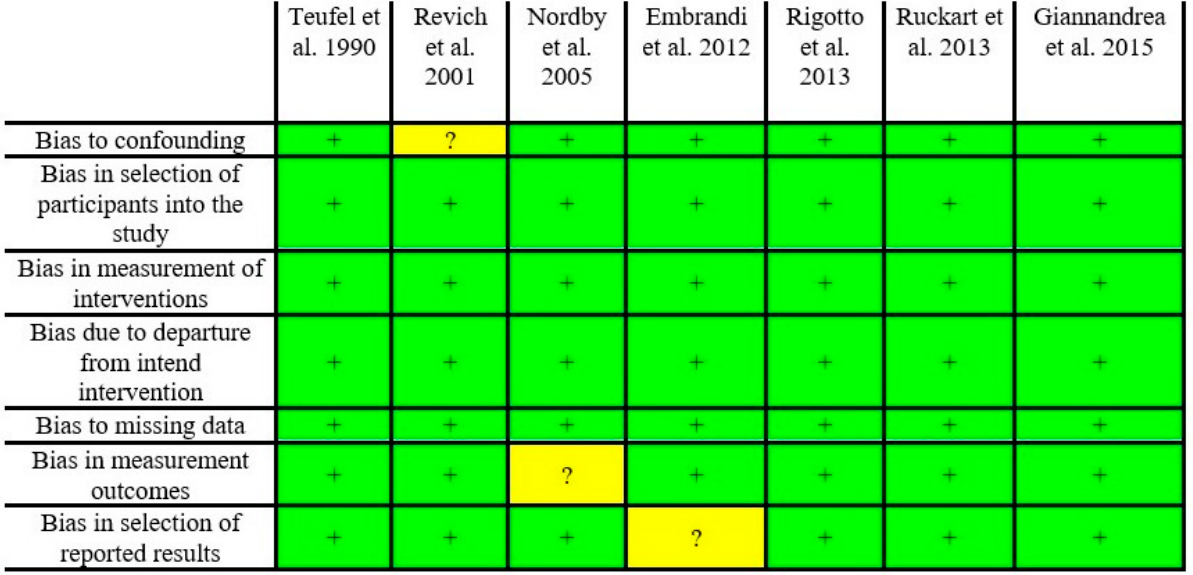
Figure 8. Risk of bias performed by ACROBAT-NRSI [57]. Green squares (+) mean a low risk of bias and yellow squares (?) mean an uncertain risk of bias [27,31,58–62].